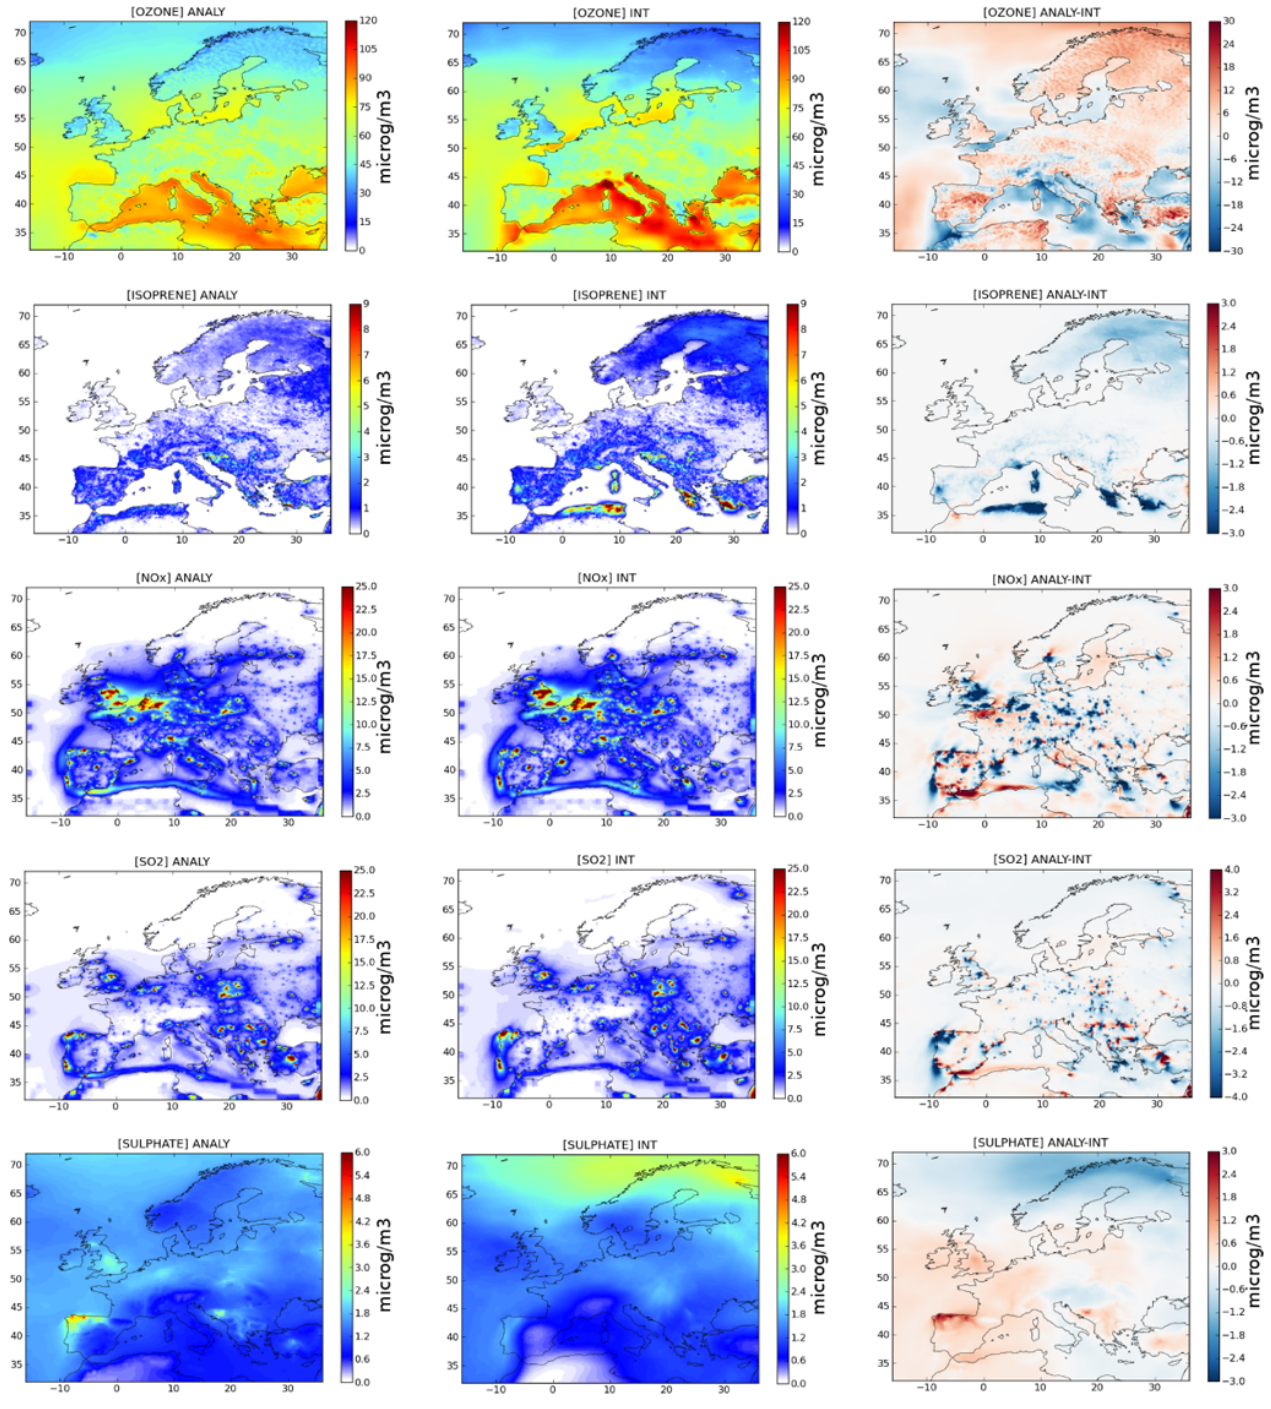
Fig. 3. From top to bottom: simulated average JJAS surface O 3 , isoprene, NO x , SO 2 and sulphate fields for ANALY and INT. Differences between ANALY and INT are shown on the right. Units are in µg m − 3